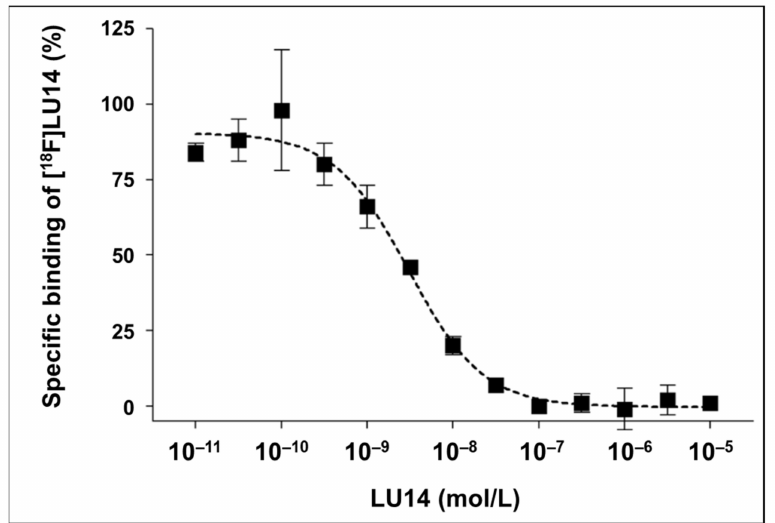
Figure 4. Receptor binding assay to determine the affinity of [ 18 F] LU14 for human CB2 receptors. Human CB2 receptors were expressed in CHO cells, and affinities were determined by competitive radioligand binding experiment using [ 18 F] LU14 at different molar activities. The inhibition curve was obtained by non-linear regression of percent specific binding (mean ± SD; one experiment run in triplicate) plotted versus the log concentration of the test